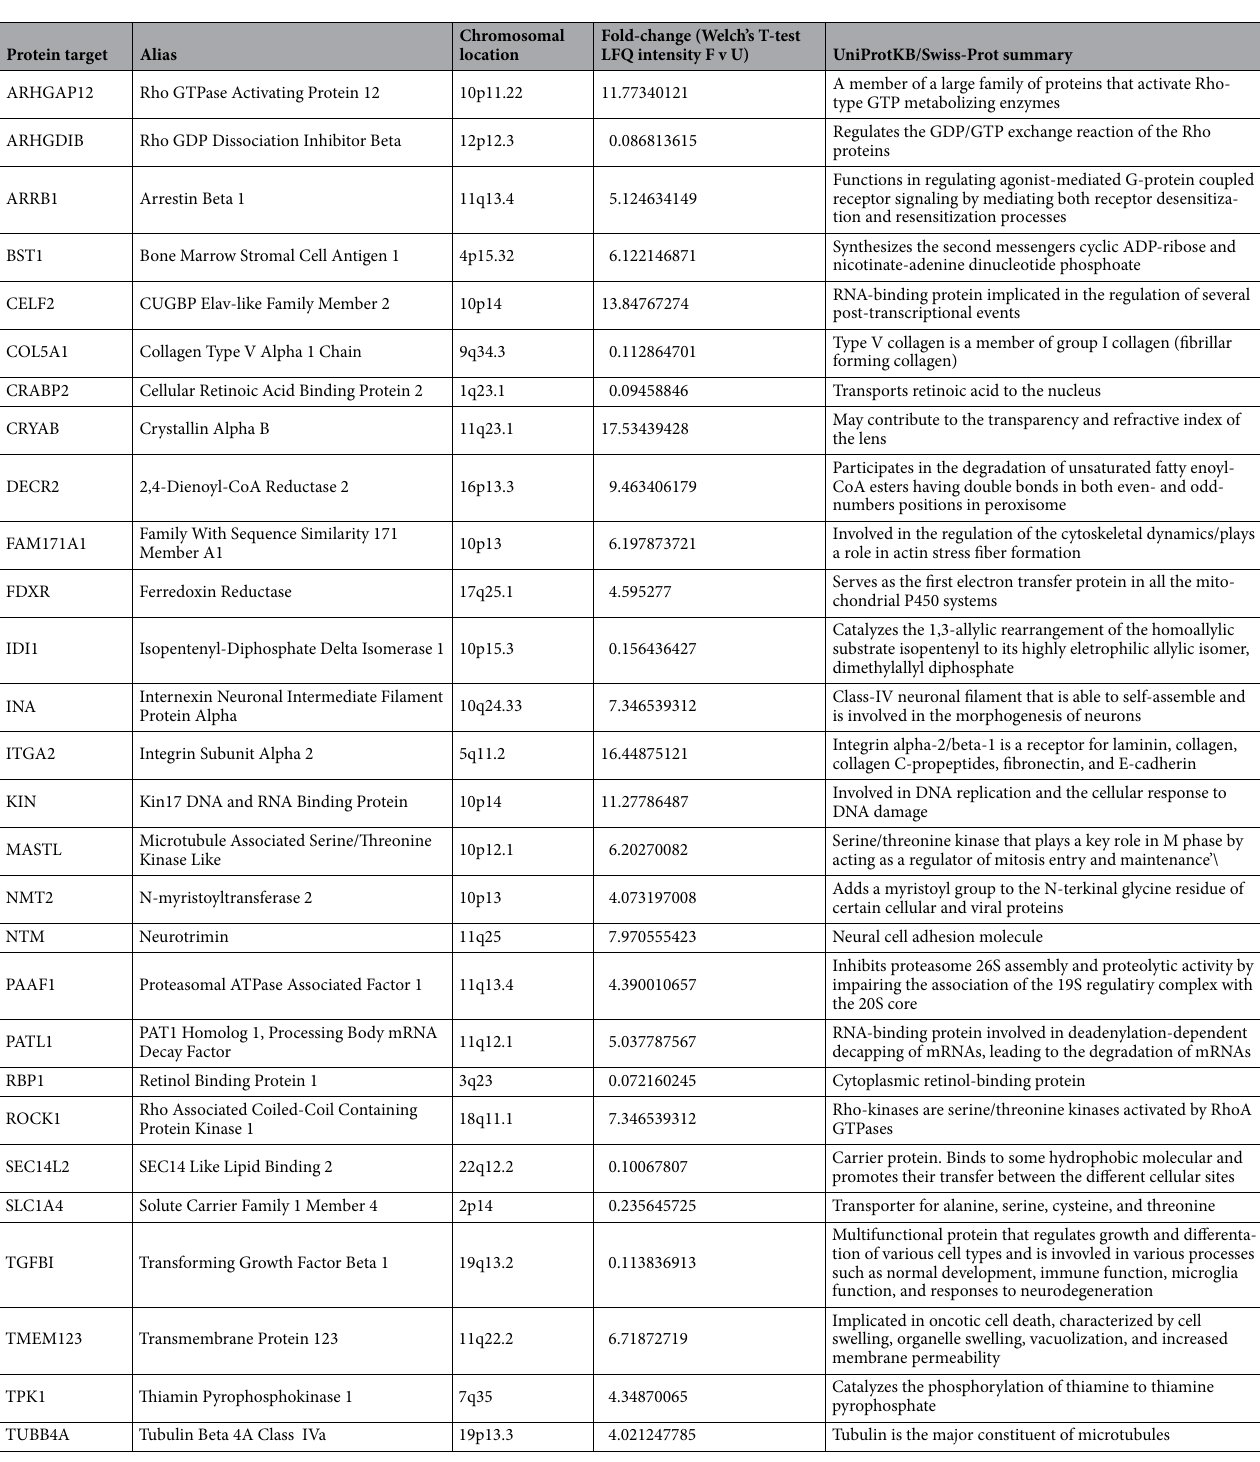
Table 3. Top upregulated and downregulated protein targets associated with gynecological cancers identified via IPA in FAC-exposed relative to Untreated FT194 cells are shown in this table, with p < 0.05 and z-value > 1.